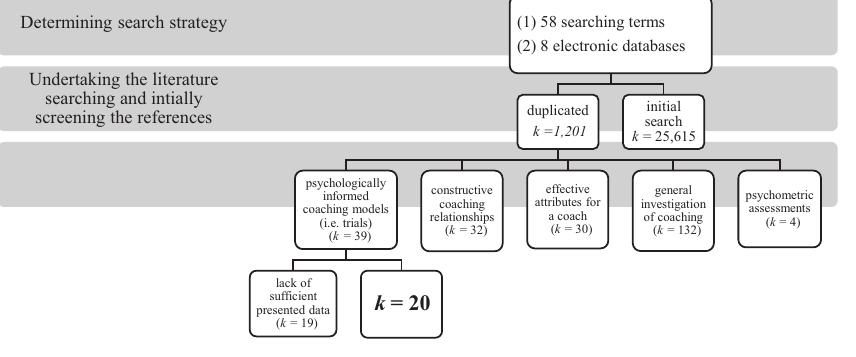
Figure 2. Literature search and